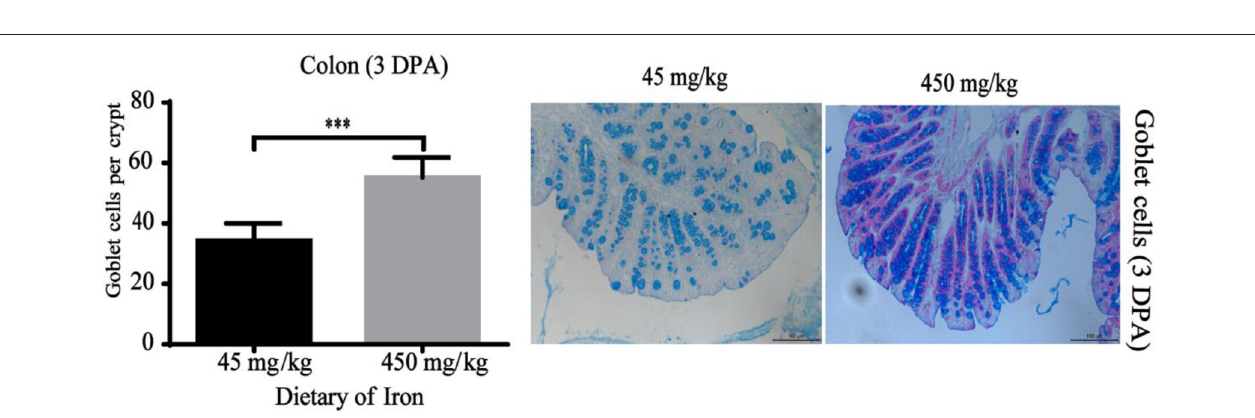
FIGURE 5 | Effects of dietary iron on intestinal epithelial goblet cell renewal in adult mice at 3 DPA . The number of goblet cells in the colonic crypt, n = 12. The 3 DPA indicates “day 3 post administration,” which is day 24 of the whole experiment cycle. Note Scale bars, 100 µ m (magnification 200 × ), *** indicates p < 0.001.